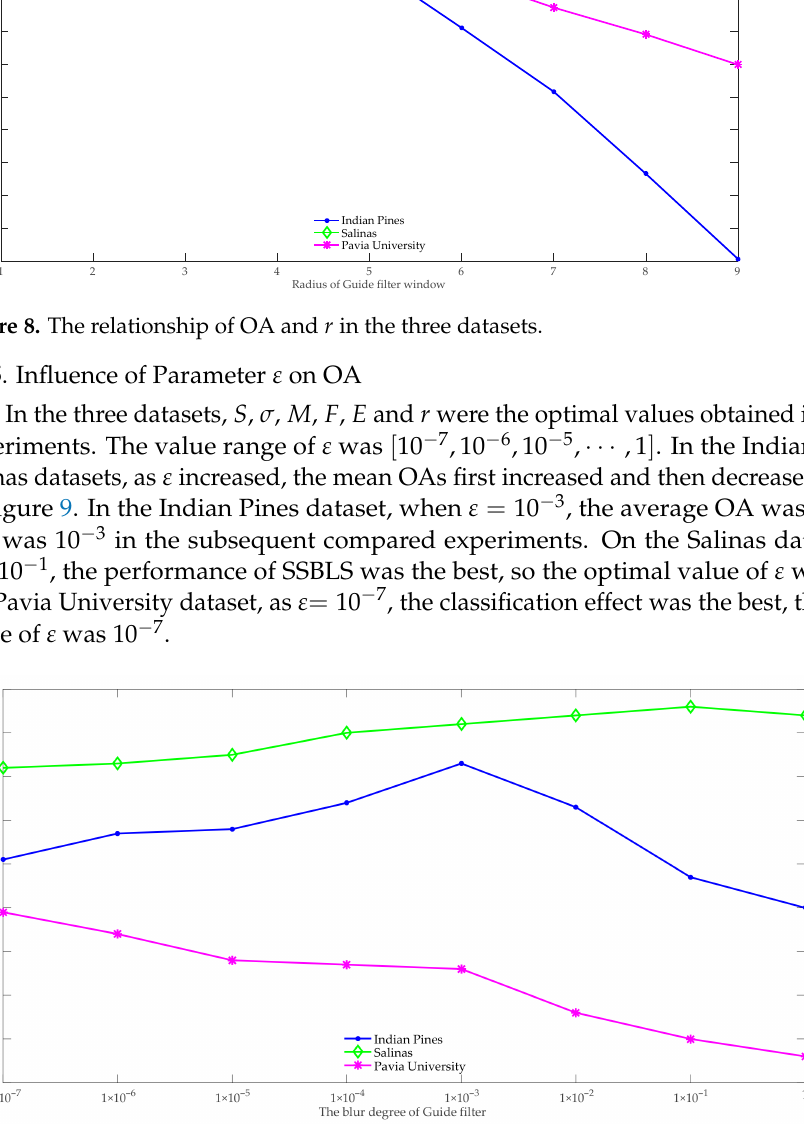
ε in the three datasets.